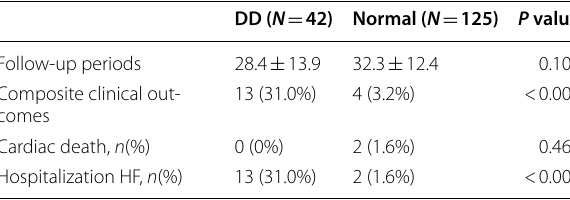
Table 3 Composite clinical outcomes